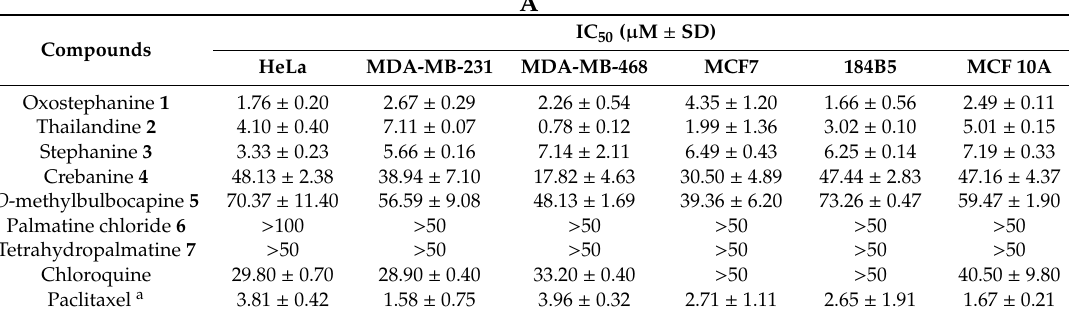
Table 2. ( A ) Anti-proliferative activities of compounds isolated from S. dielsiana Y.C. Wu extracts. ( B ) Selectivity index (SI) of cancer (MDA-MB-231, HeLa, MCF7 and MDA-MB-468) versus non-cancer (184B5 and MCF10A) cell lines for selected compounds from S. dielsiana Y.C.